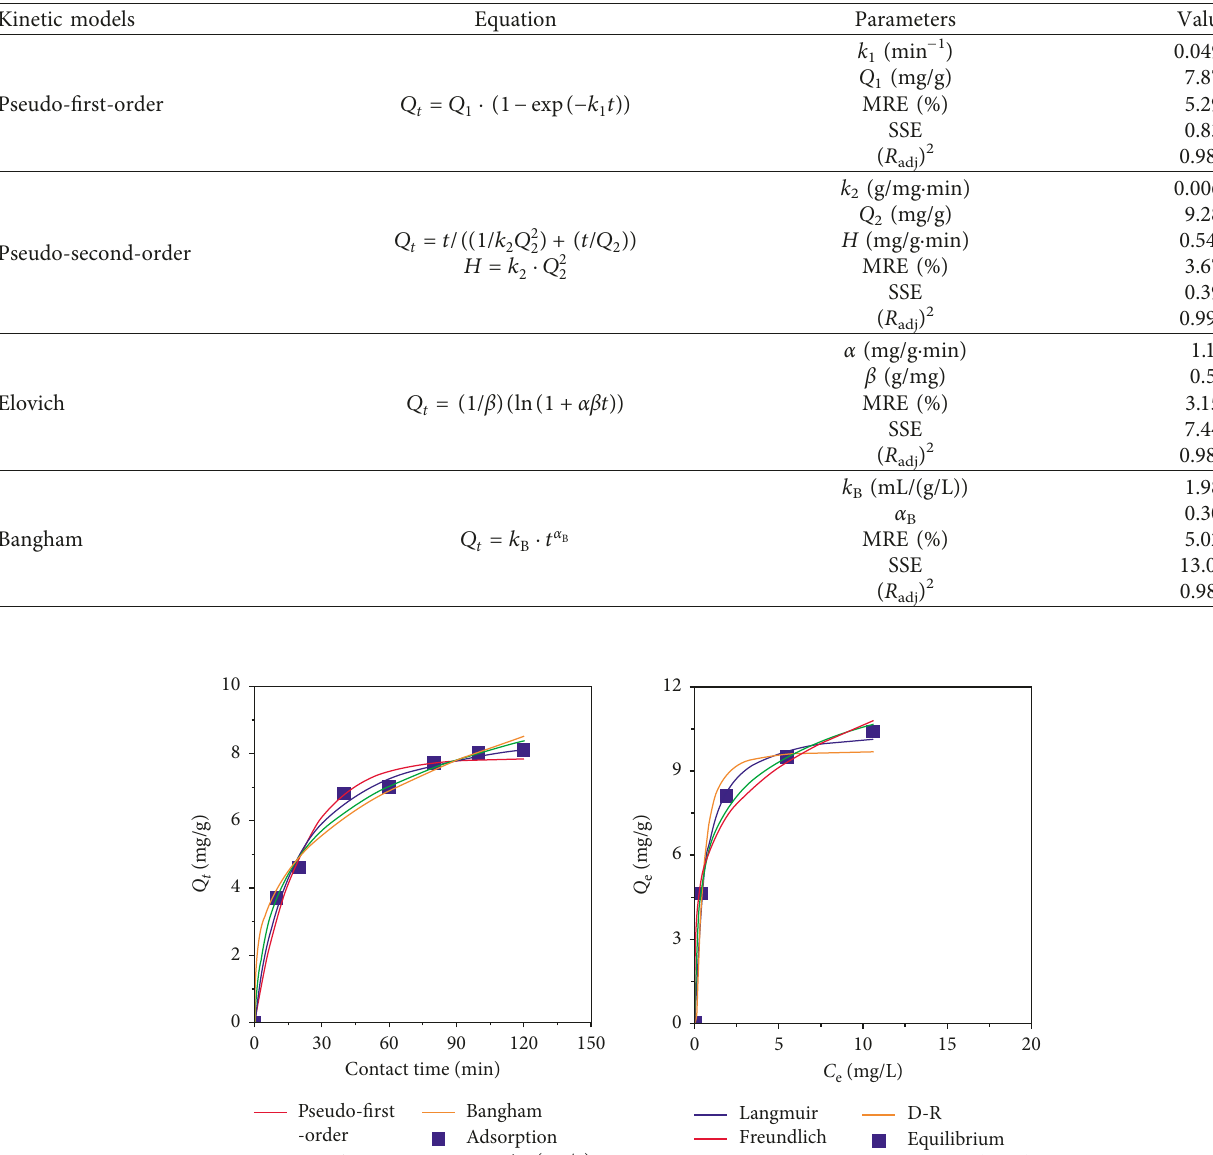
Table 6: Nonlinear kinetic constants for the adsorption of IBU over MIL-53(Fe).